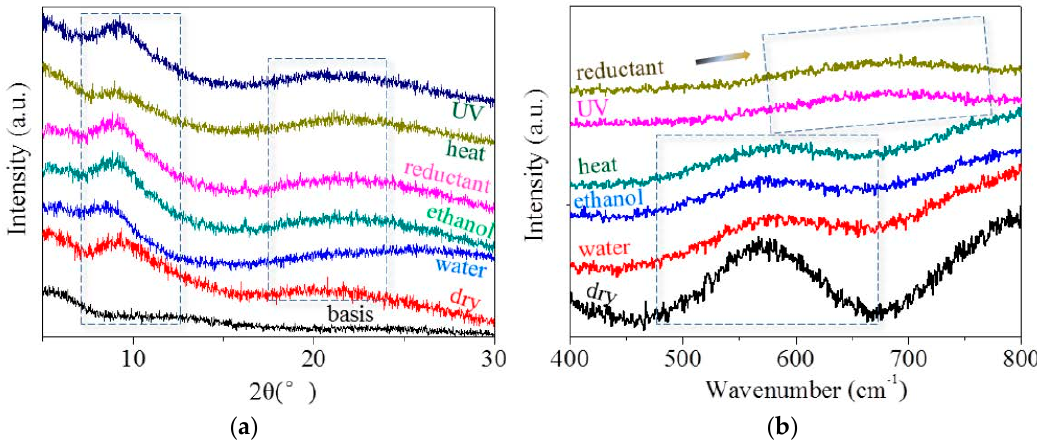
Figure 8. Structural component characterization of goat guard hairs under original (dry), wet (water), soaked in ethanol, reductant (NaHSO 3 , 1 M/L) solution, heat, and UV-radiation conditions: ( a ) XRD raw data of each hair state on the basis of baseline data; ( b ) Raman spectra for characterizing the disulfide bonds of goat hairs.